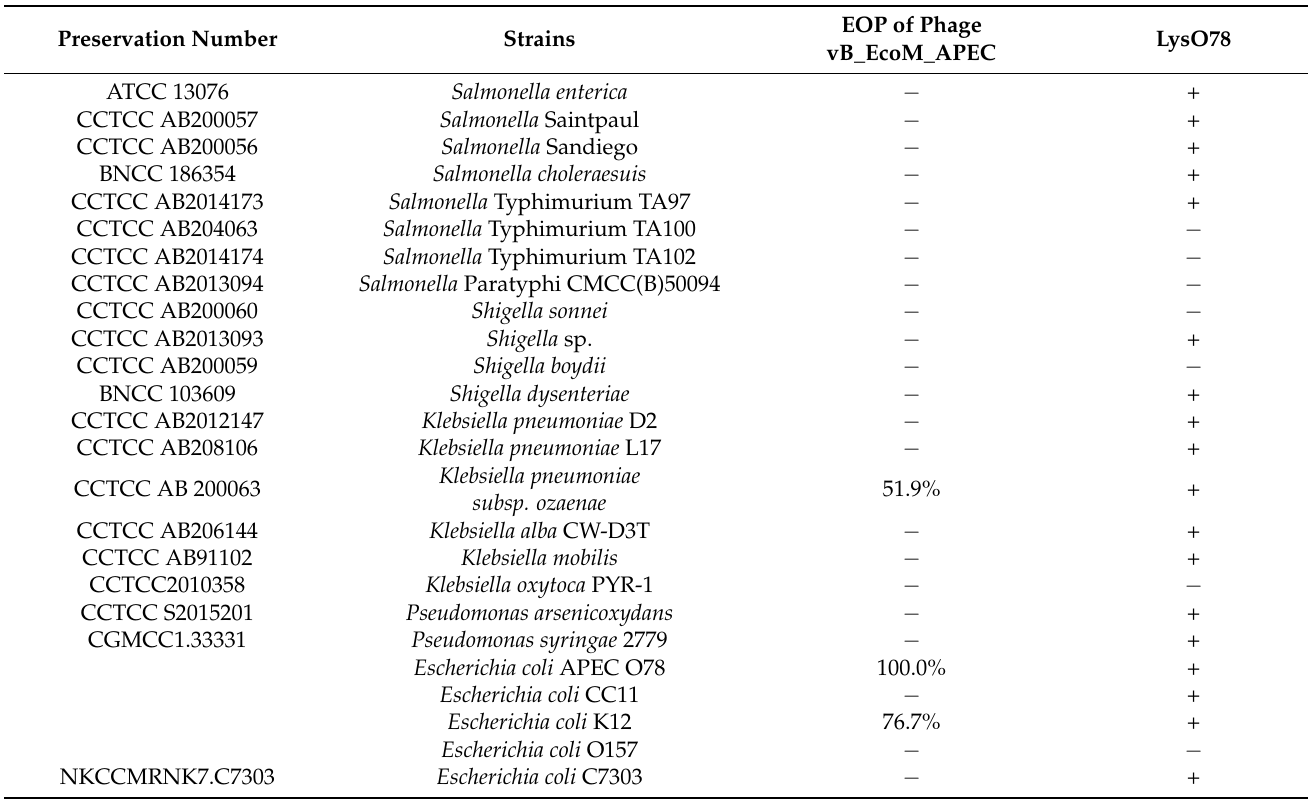
Table 1. The host range of the phage vB_EcoM_APEC and the lytic spectrum of endolysin LysO78. Preservation